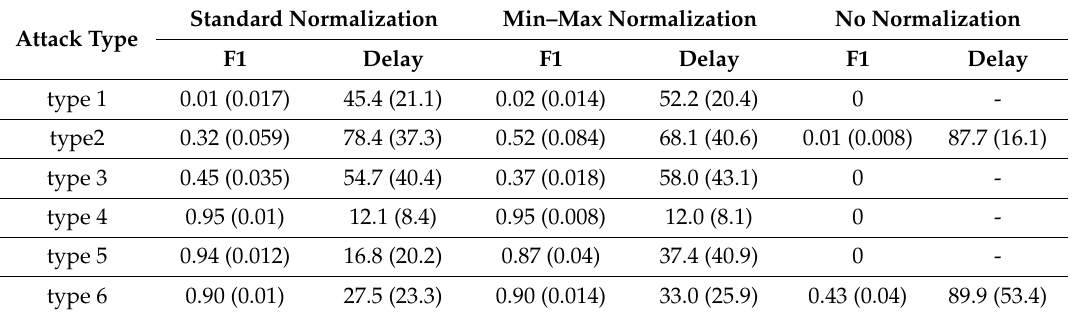
Figure 1. Illustration of experimental setting. Red circles denote the attack data generated from the normal data. If the symbols of attack data and normal data are same, it means that attack data was generated from the normal data of the same customer. ( a ) when model construction is based on the normal energy consumption data of consumers unrelated to testing and a test data stream is composed of the normal data of one user and attack data generated from that normal data. ( b ) when model construction is based on the normal energy consumption data of consumers unrelated to testing and a test data stream is composed of the normal data of one user and the attack data generated from another random user’s data. ( c ) when model construction is based on the previous energy consumption data of the consumer being tested. Table 1. The energy theft detection performance for a test data stream composed of the normal data of one user and attack data generated from that normal